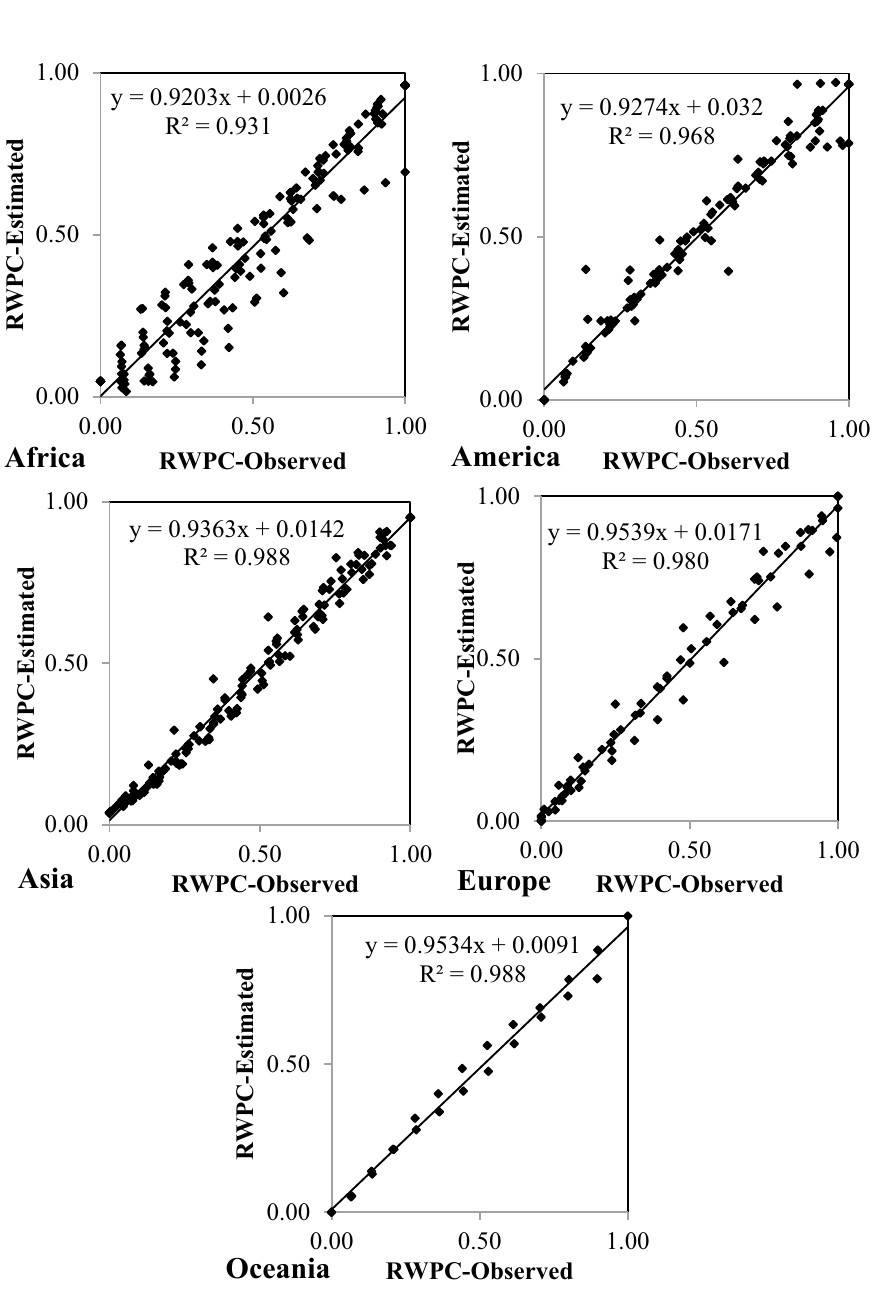
Figure 13. Observed and estimated RWPC parameters during the test period in the world’s